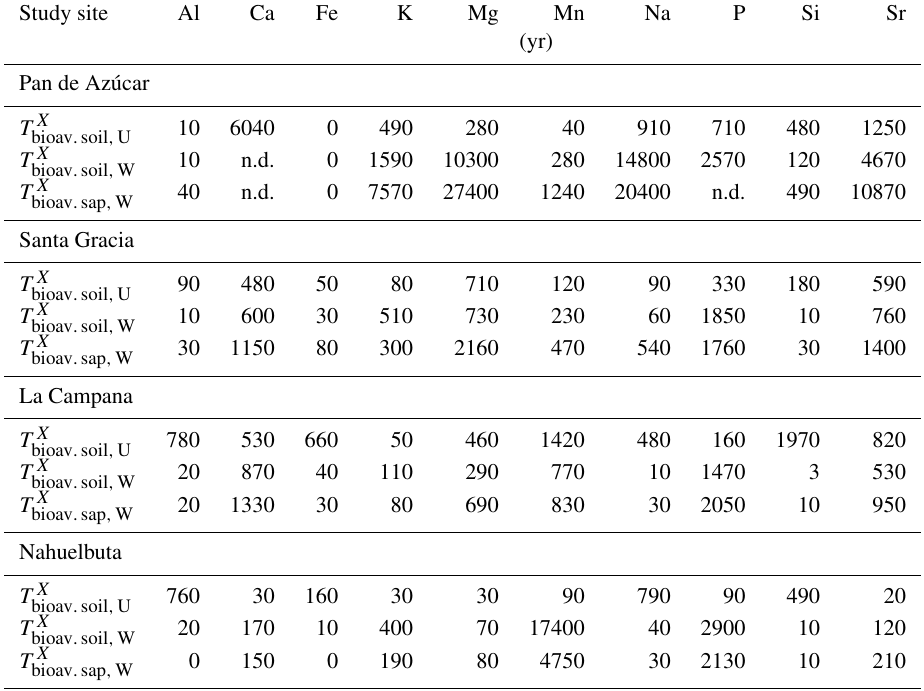
Table A3. Turnover times for the soil and saprolite bioavailable fraction with respect to the release by weathering and turnover times for bioavailable fraction in soil with respect to uptake into plants.